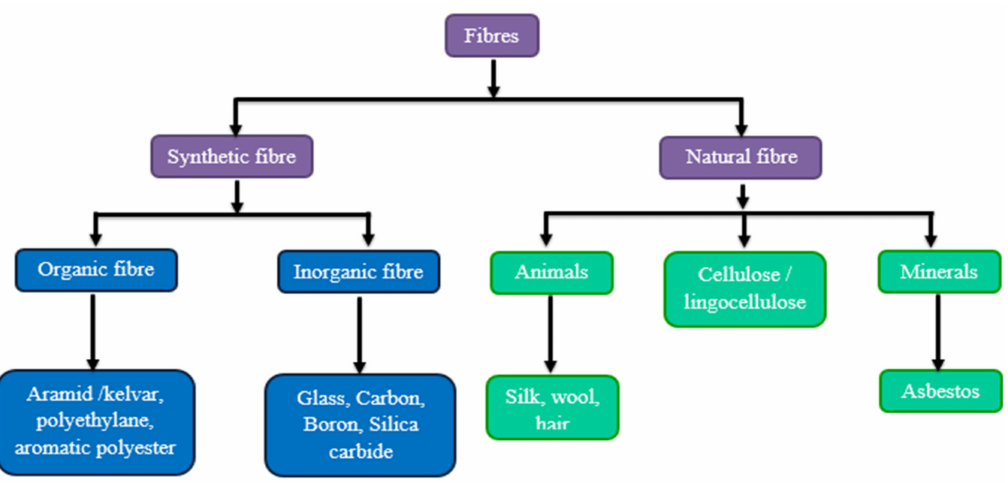
Figure 1. Flow chart of different types of fibers for the reinforcement phase.